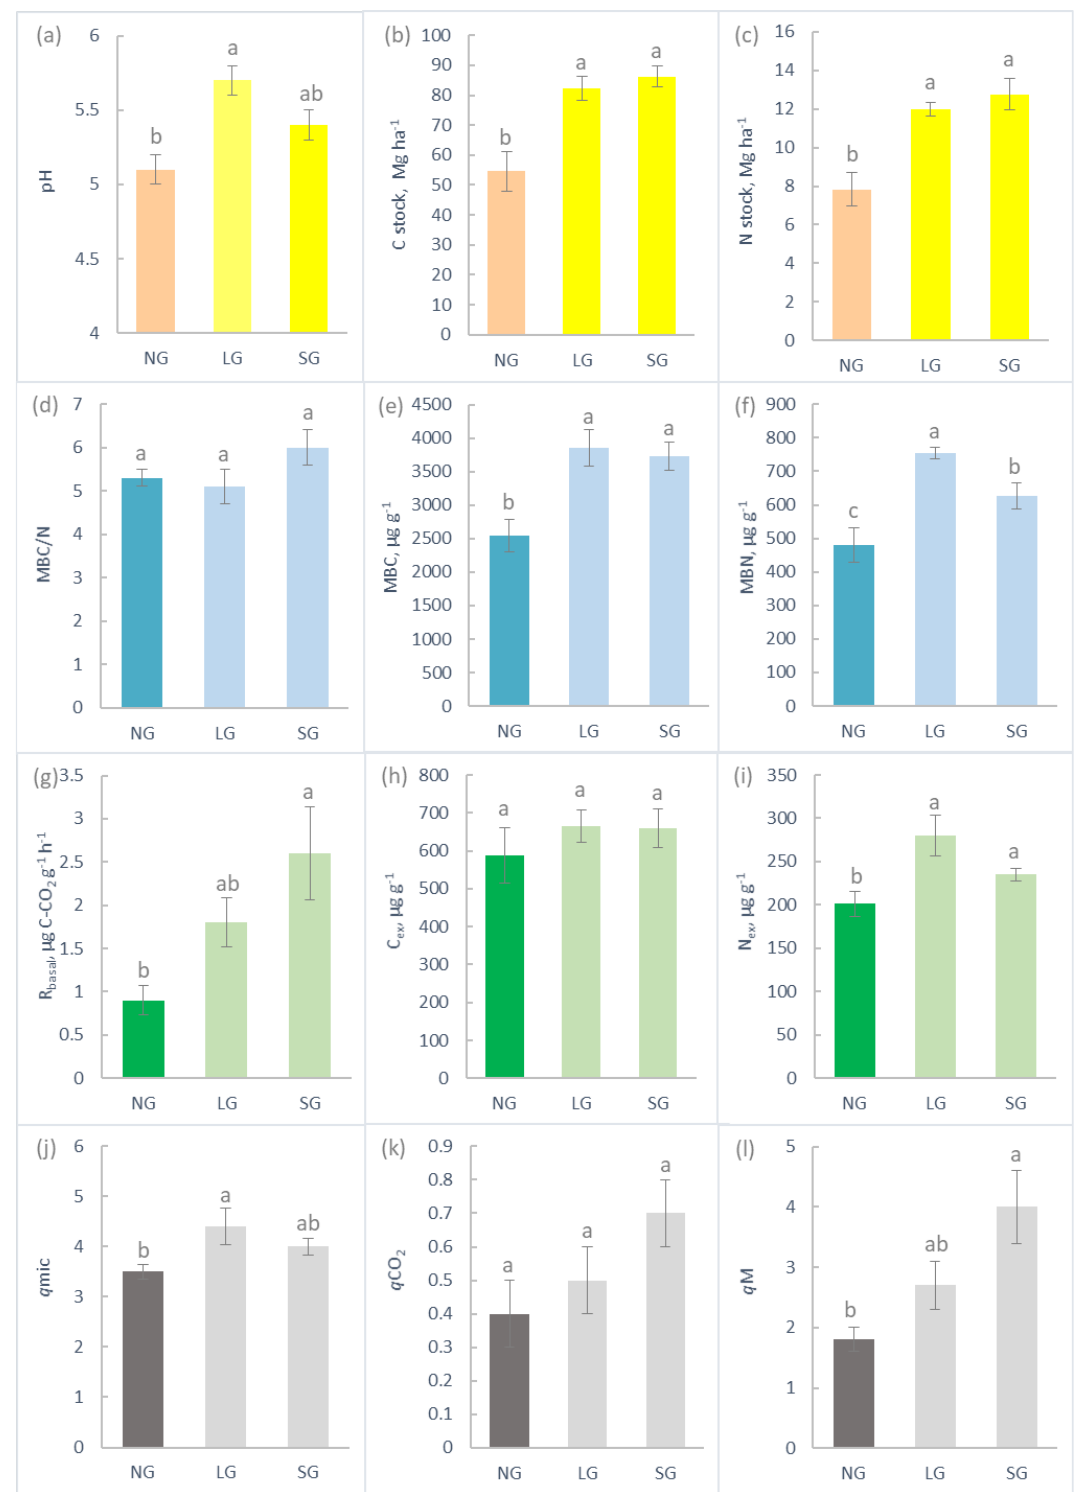
Figure 3. Soil chemical and biochemical characteristics measured in NG, LG and SG plots (mean ± standard error): ( a ) pH in water solution; ( b ) soil C stock; ( c ) soil N stock; ( d ) C/N microbial ratio (MBC/N); ( e ) microbial biomass C (MBC); ( f ) microbial biomass N (MBN); ( g ) microbial basal respiration (R basal ); ( h ) soil extractable C (C ex ); ( i ) soil extractable N (N ex ); ( j ) soil microbial quotient ( q mic); ( k ) soil metabolic quotient ( qCO 2 ); ( l ) soil mineralization quotient (q M ). Letters next to the bars show the significance of ANOVA at p <